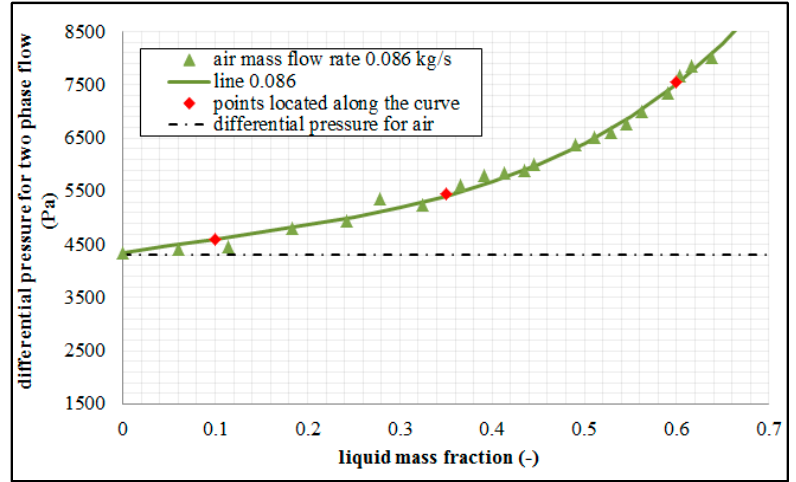
Figure 7. Dependence of differential pressure depending on mass fraction of liquid in the air flow.